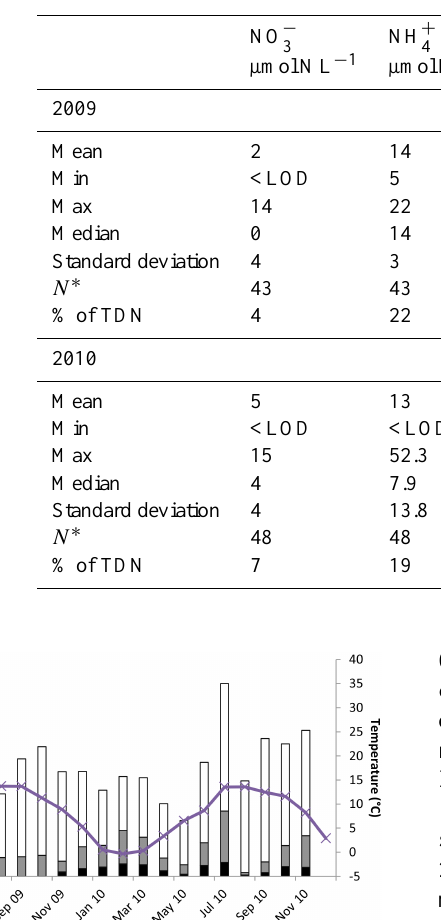
Table 3. Statistics of annual concentrations of NH + samples collected over the 2-year period. N ∗ indicates the number of samples collected.